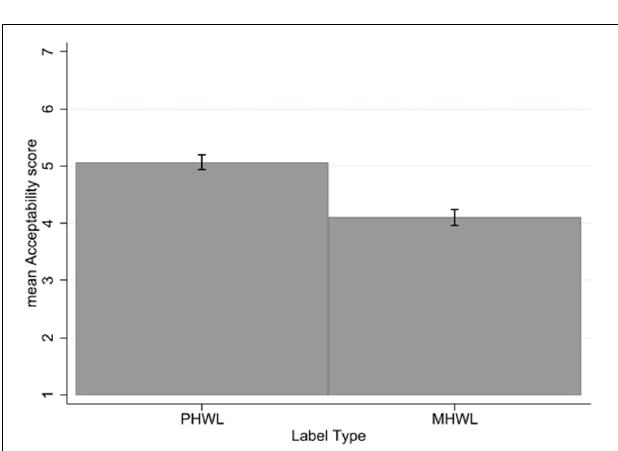
FIGURE 6 | Acceptability by label type. Error bars represent 95% confidence intervals.